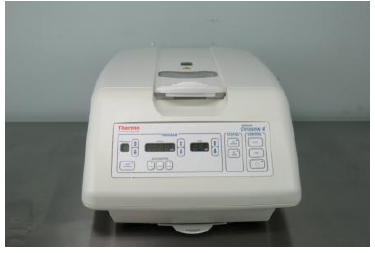
Figure 2. Example of cytocentrifuge.